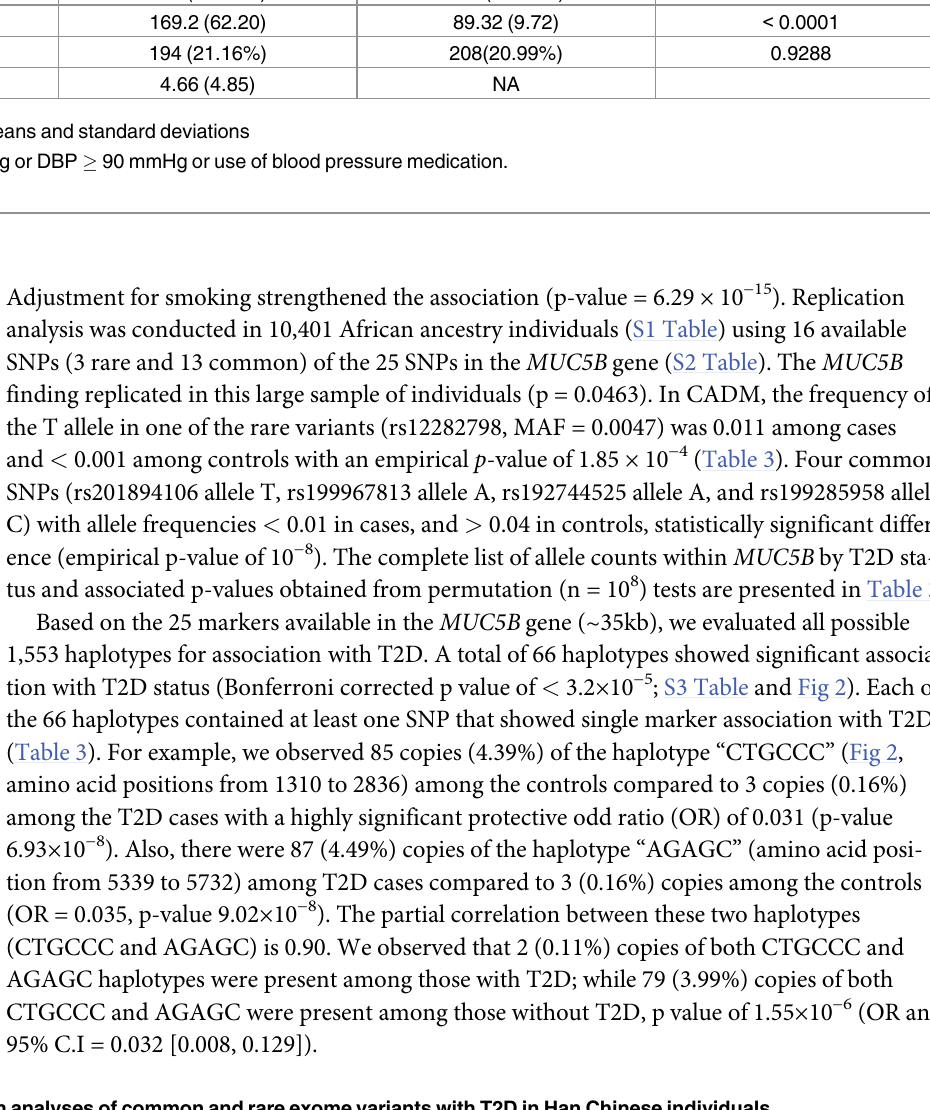
Table 2. Top results for the joint association analyses of common and rare exome variants with T2D in Han Chinese individuals. Genes